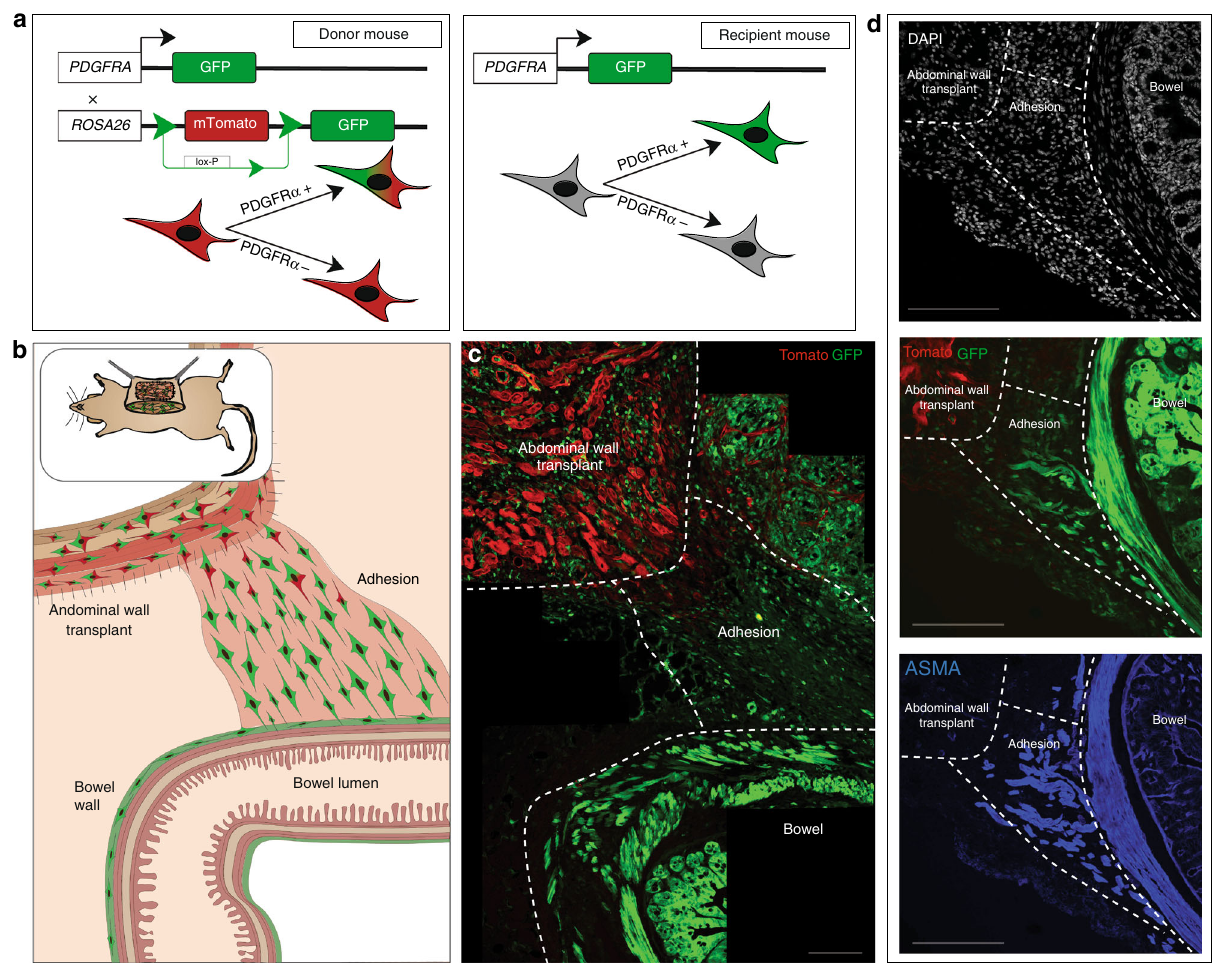
Fig. 3 Adhesion fi broblasts derive primarily from the viscera. a Schematics of the PDGFRA GFP ::ROSA26 mTmG mouse “ donor ” model (left panel) and PDGFRA GFP “ recipient ” model (right panel). b Schematic for abdominal wall transplant model using abdominal wall from PDGFRA GFP ::ROSA26 mTmG mice, transplanted into PDGFRA GFP mice, followed by adhesions surgery. c Confocal imaging of representative abdominal wall transplant model mouse adhesion tissue shows a prominence of GFP + cells within the adhesion interface, relative to GFP-mTomato + cells, harvested at POD 14. White dotted lines mark structures as labelled in images, confocal imaging. n = 5 biological replicates. Scale bar, 100 μ m. d Confocal imaging of the abdominal wall transplant model representative tissue shows PDGFRA/ASMA co-expression (PDGFRA labelled with GFP using the mTmG mouse model, IF staining for ASMA) among the cells migrating from the visceral peritoneum into the adhesion interface. White dotted lines mark structures as labelled in images, confocal imaging. n = 5 biological replicates. Scale bars, 100 μ